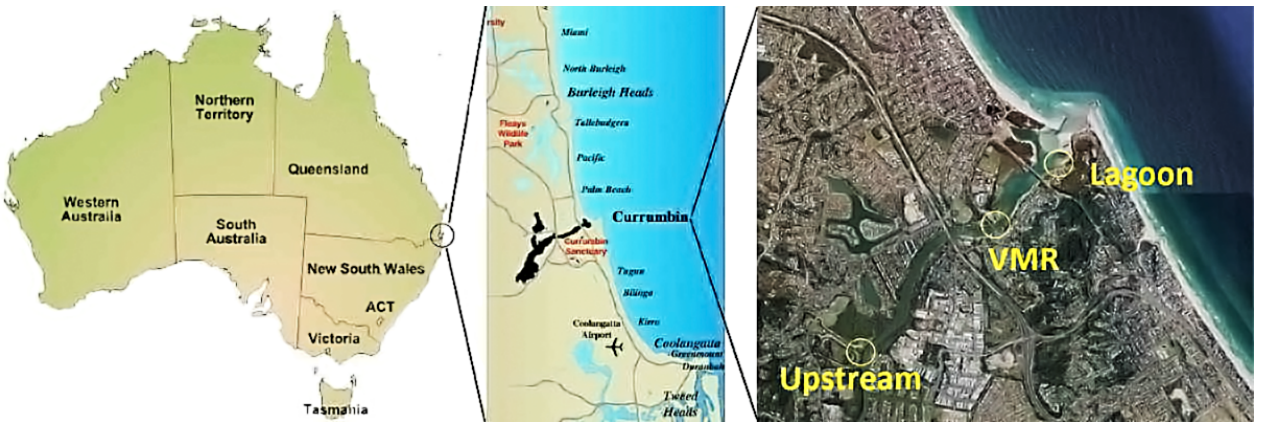
Fig. 1. Study Area, Currumbin Creek and approximate location of the creek